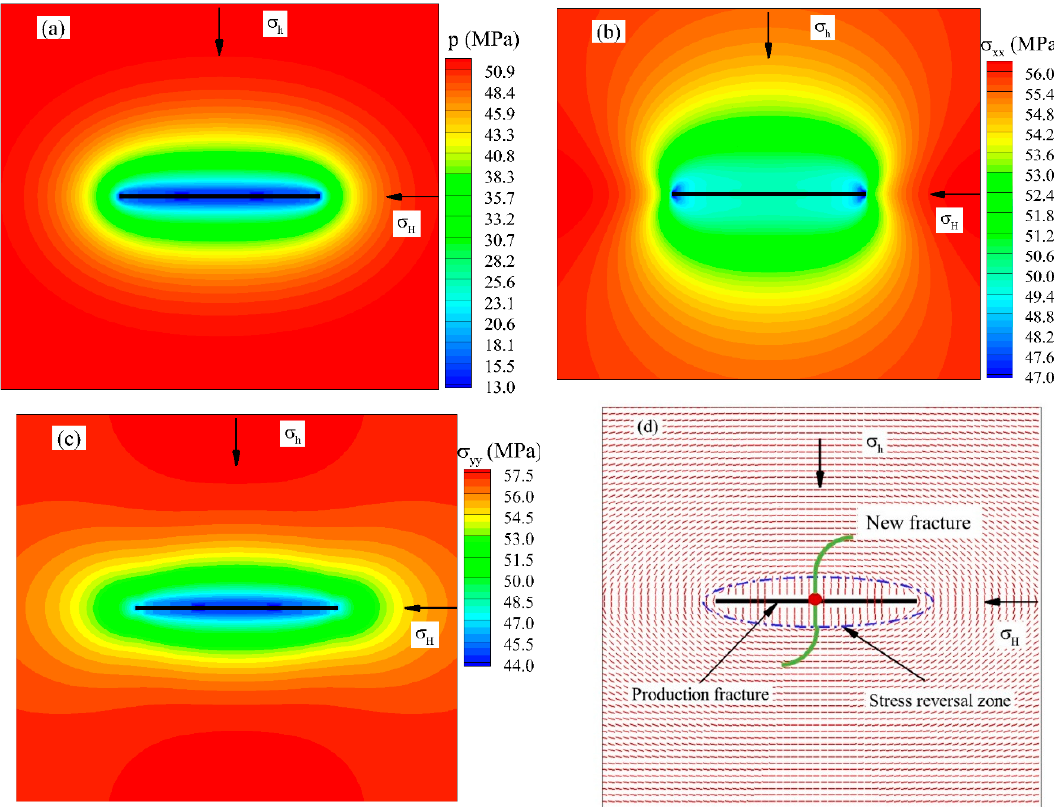
Figure 1. A schematic showing ( a ) plan-view of depletion-induced reservoir pore pressure around a production fracture, ( b ) horizontal stress component perpendicular to the fracture surface, ( c ) horizontal stress component parallel to the fracture surface, and ( d ) stress reversal zones around a production fracture. The dotted lines show trajectories of the local maximum principal stress.